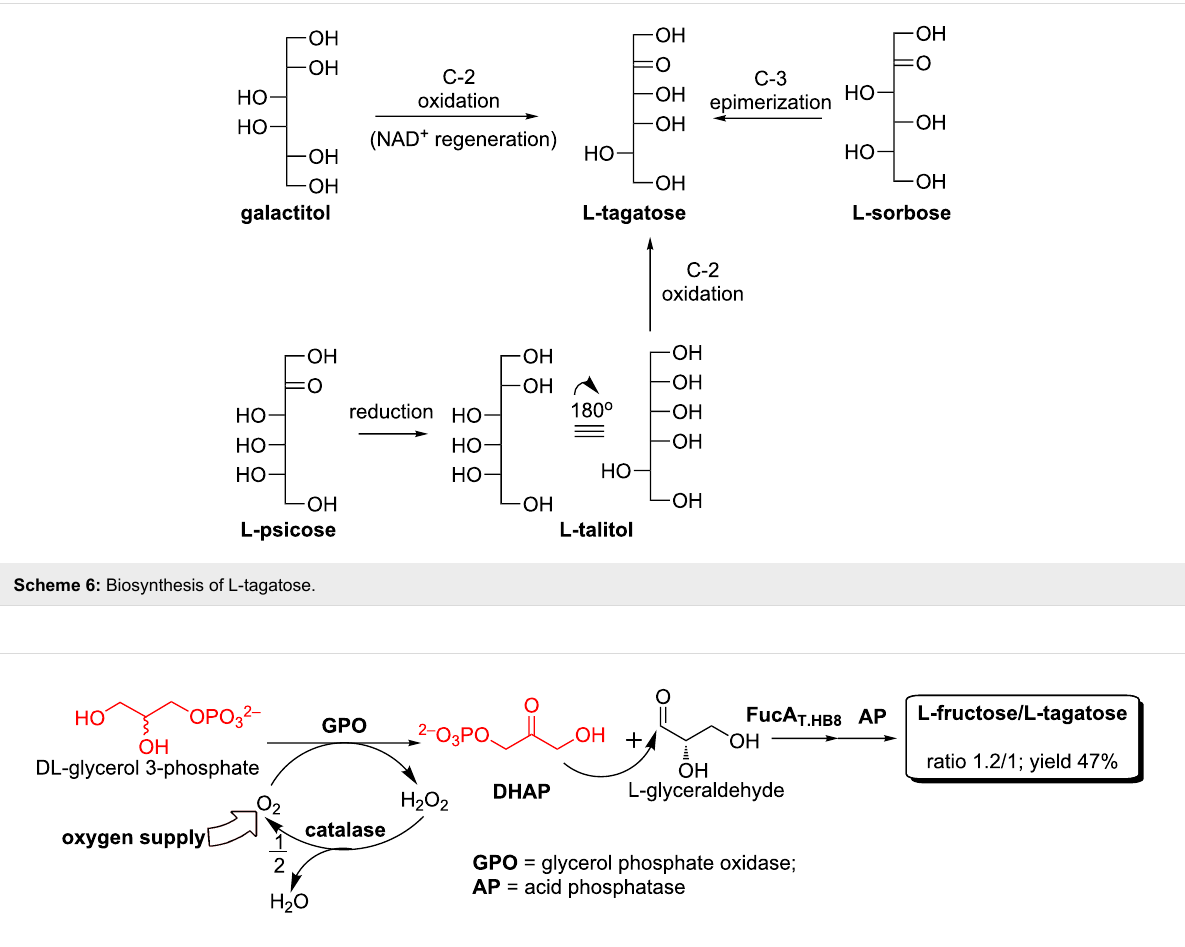
Scheme 7: Preparative-scale synthesis of L-tagatose and L-fructose using aldolase.